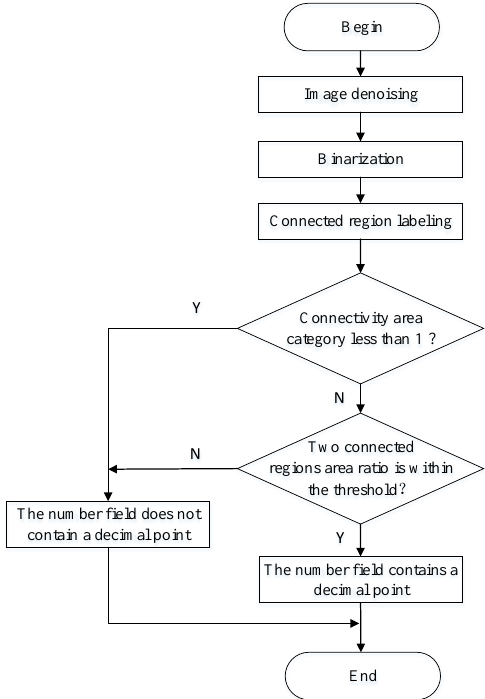
Figure 5. Digital area connected domain analysis algorithm flow chart.